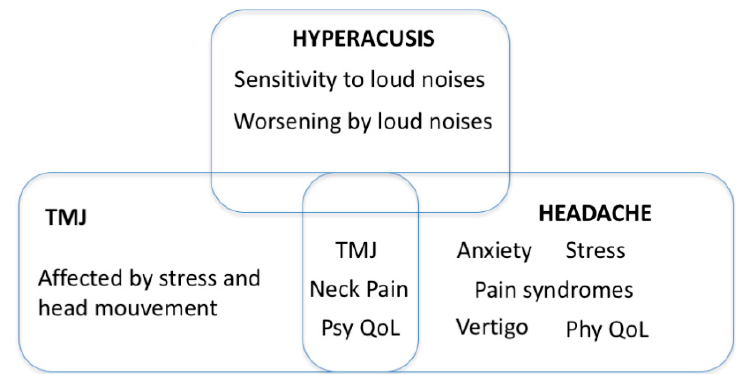
Figure 1. Phenotypes from tinnitus participants with hyperacusis are distinct from those with headaches or temporomandibular joint complaints. Venn Diagram describing the variables from participants with severe tinnitus (THI ≥ 58) that differ between those having TMJ complaints or not [42], those reporting headache or not [52], or hyperacusis or not (the present study). TMJ complaints, neck pain and psychological quality of life (Psy QoL) are found common to TMJ complaints and headache, whereas hyperacusis does not share any of the features appearing in participants with TMJ complaints or headache.